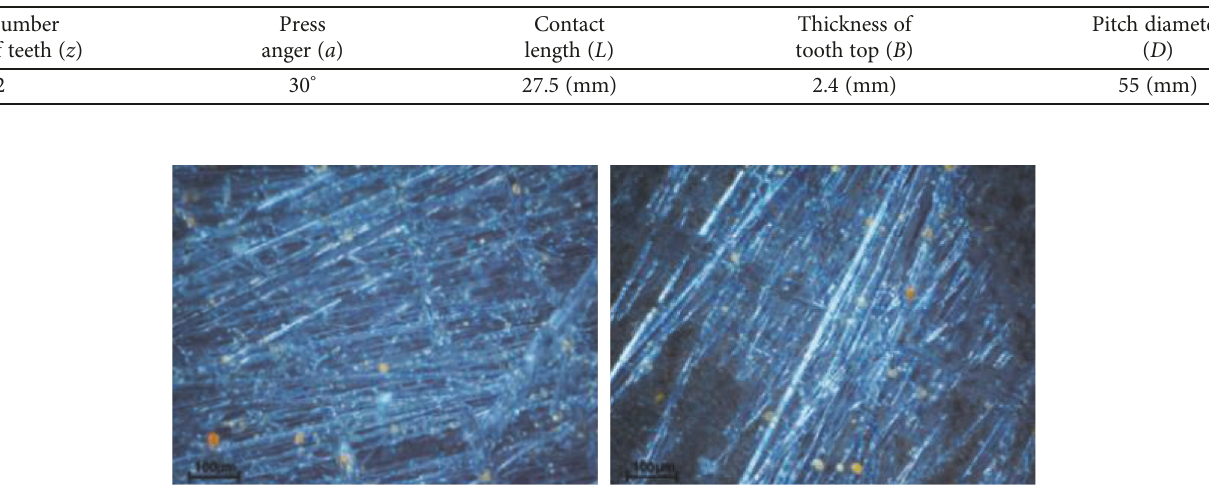
Table 8: Geometric parameters of fl oating involute